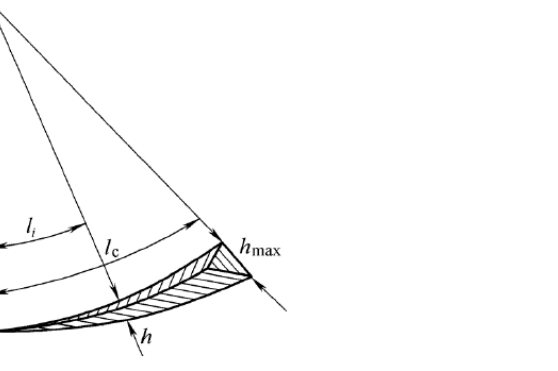
Figure 3. Interference between a single abrasive particle and the workpiece. 2.3. Number of Effective Abrasive Particles Per Unit Area on the Surface of the Dicing Blade The dicing blade was sampled and observed many times under an Hitachi S-3400N scanning electron microscope. The distribution of abrasive particles on the surface is